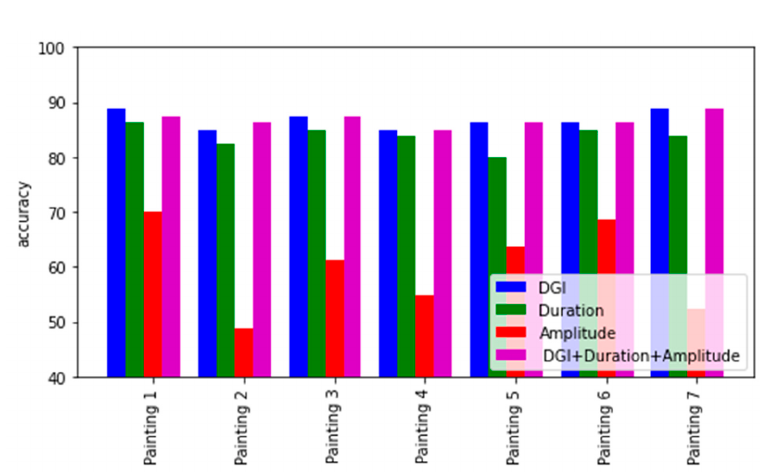
Brain Sci. 2022 , 12 , x FOR PEER REVIEW Figure A19. support vector machine scores for the seven DGI based data sets. Figure A19. Support vector machine scores for the seven DGI based data sets.